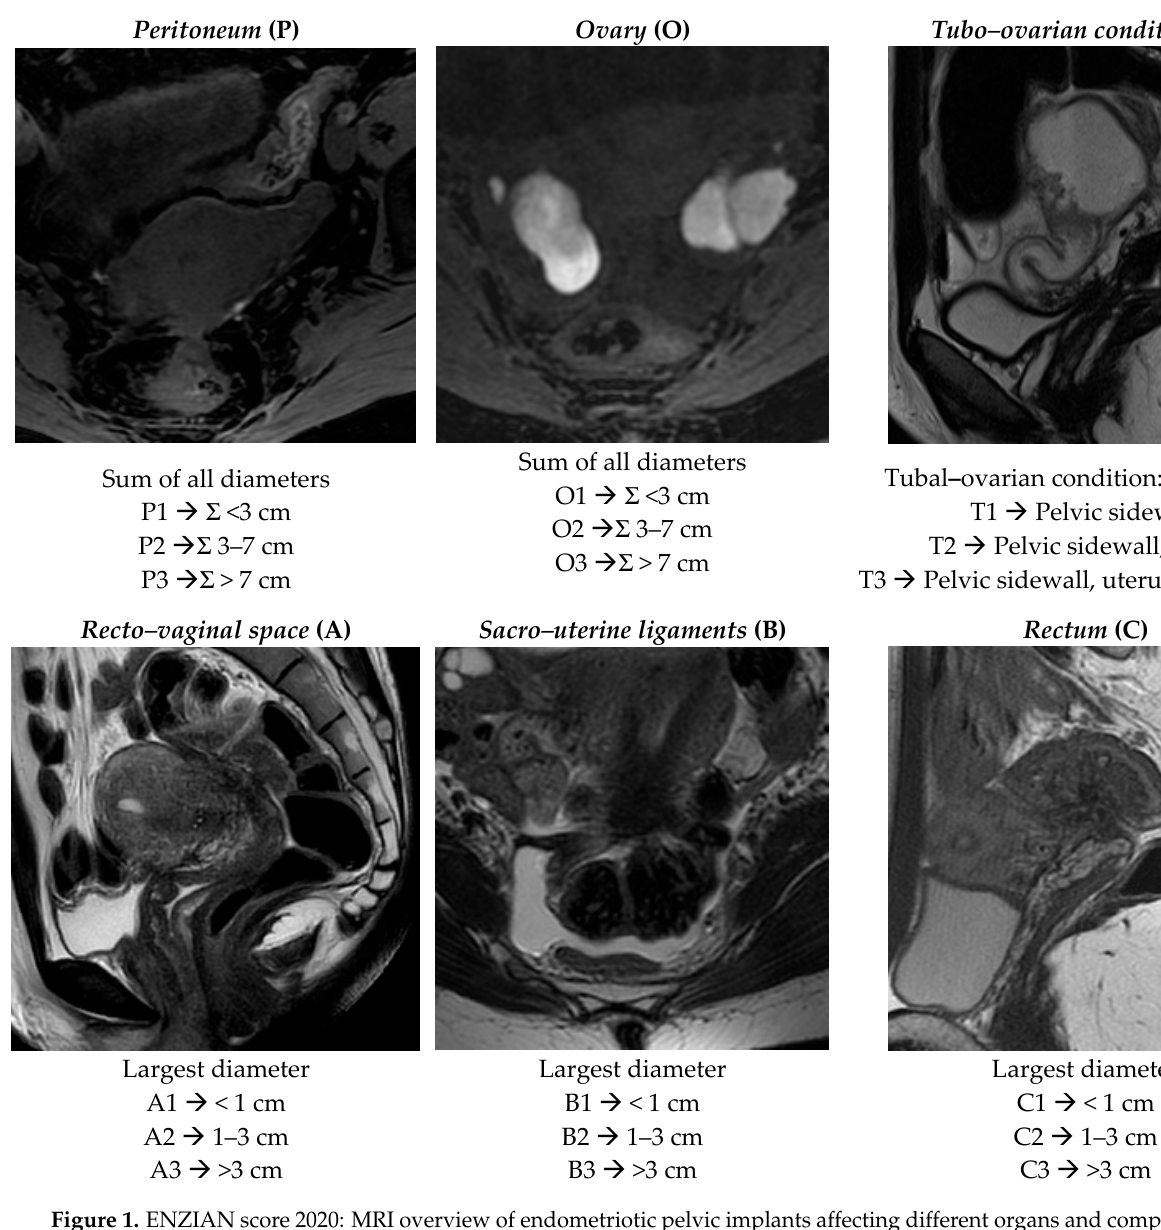
Figure 1. ENZIAN score 2020: MRI overview of endometriotic pelvic implants affecting different organs and compart- ments.